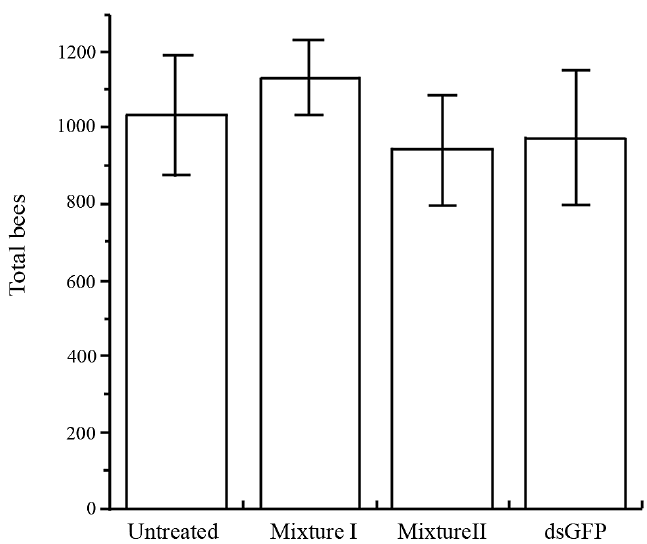
Figure 6. Mean ( + SE) total number of bees (capped brood and adults) in four treatments. Treatments did not differ significantly.